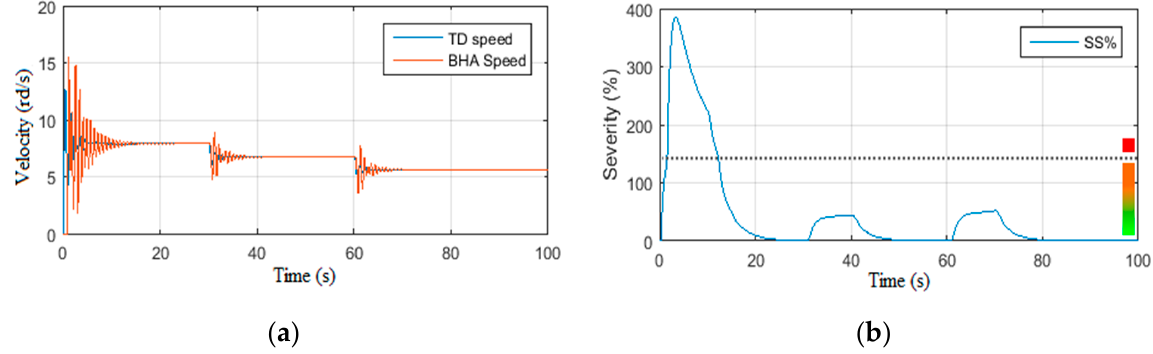
Figure 5. Scenario 1.1 open loop responses: ( a ) Rotational Velocities of Top drive and Drill bit, ( b ) Stick-slip severity.